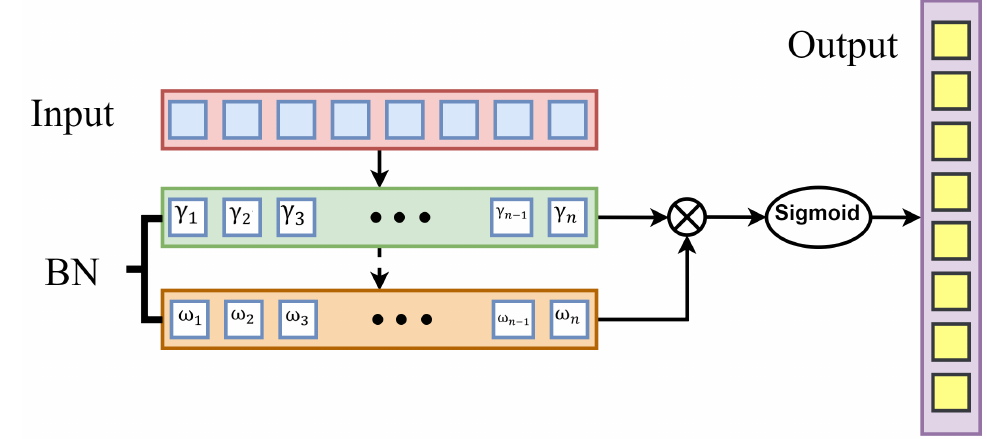
Figure 4. Channel Attention